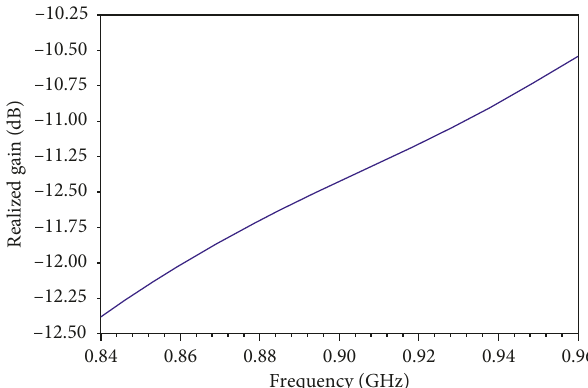
Figure 6: Simulated realized gain versus frequency of the first proposed epidermal tag over the human body reference model.